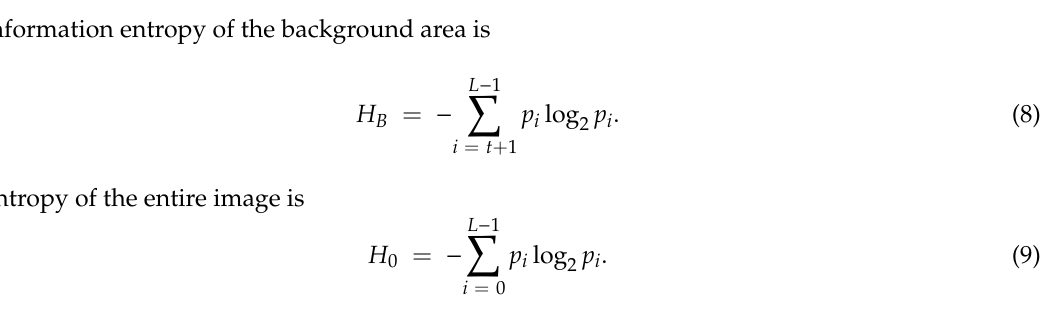
Figure 5. Results of image segmentation: ( a ) original image; ( b ) segmented image.